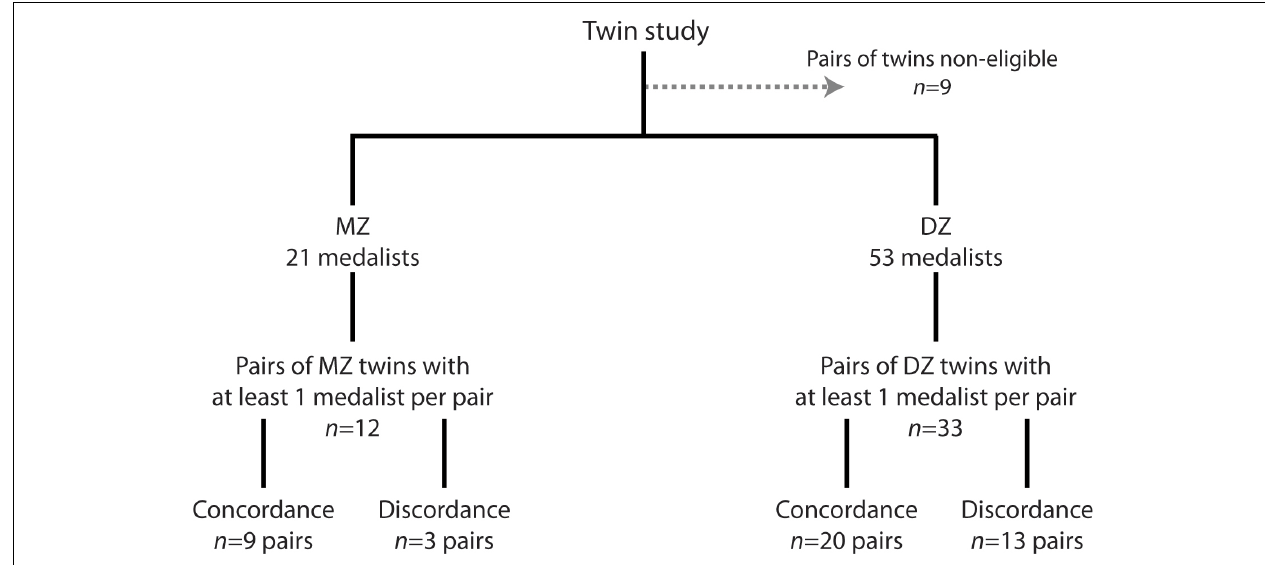
FIGURE 2 | Twin study flow